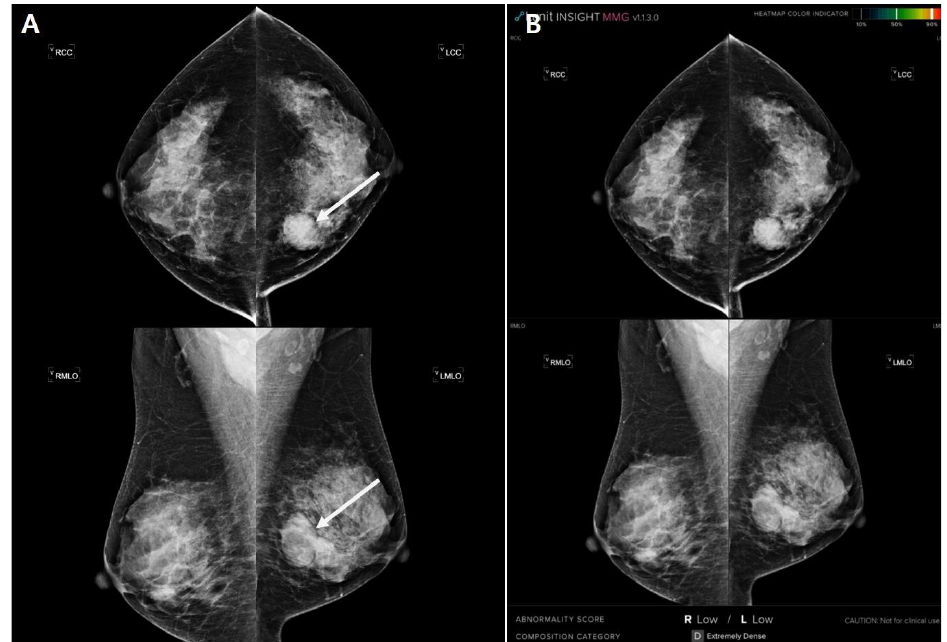
Figure 1. An invisible case in AI that is concordant only in radiologist’s analysis. A 53-year-old woman presented at the hospital with a palpable mass of her left breast. ( A ) Mammography showed a dense breast with a 3.7-cm-sized well-circumscribed oval mass in the left mediocentral breast (arrows). ( B ) Artificial intelligence revealed no abnormal lesion on the mammogram. The largest malignancy probability score was 0.85% of the left craniocaudal view and the abnormality score of the case was shown as ‘low’. The patient underwent ultrasound-guided core needle biopsy. She was diagnosed with invasive mucinous